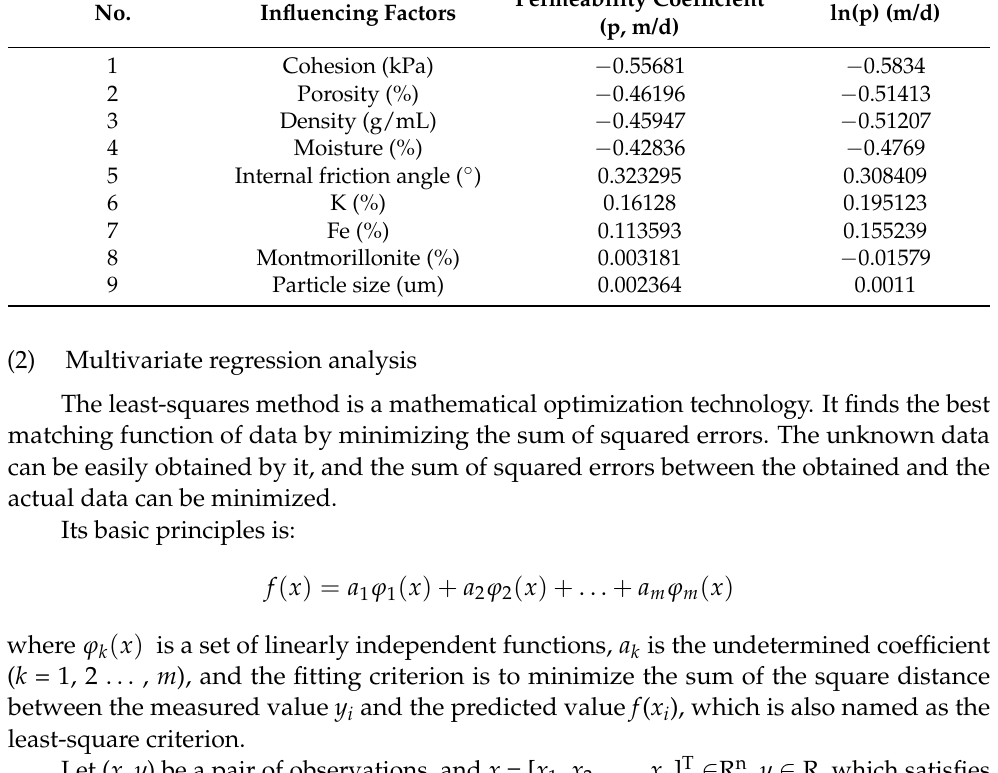
Table 2. Table of correlation coefficients between permeability coefficient and its influencing factors. Permeability Coefficient No. Influencing Factors